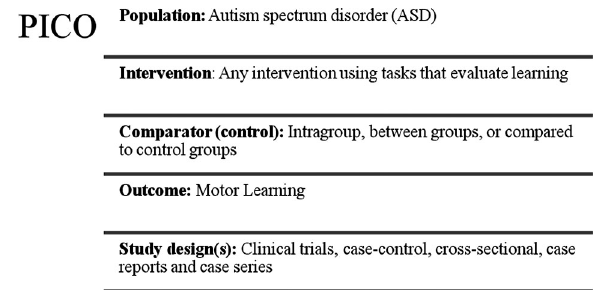
Figure 1. Representation of the search strategy – according to the Popu- lation Intervention Comparison Outcome (PICO)